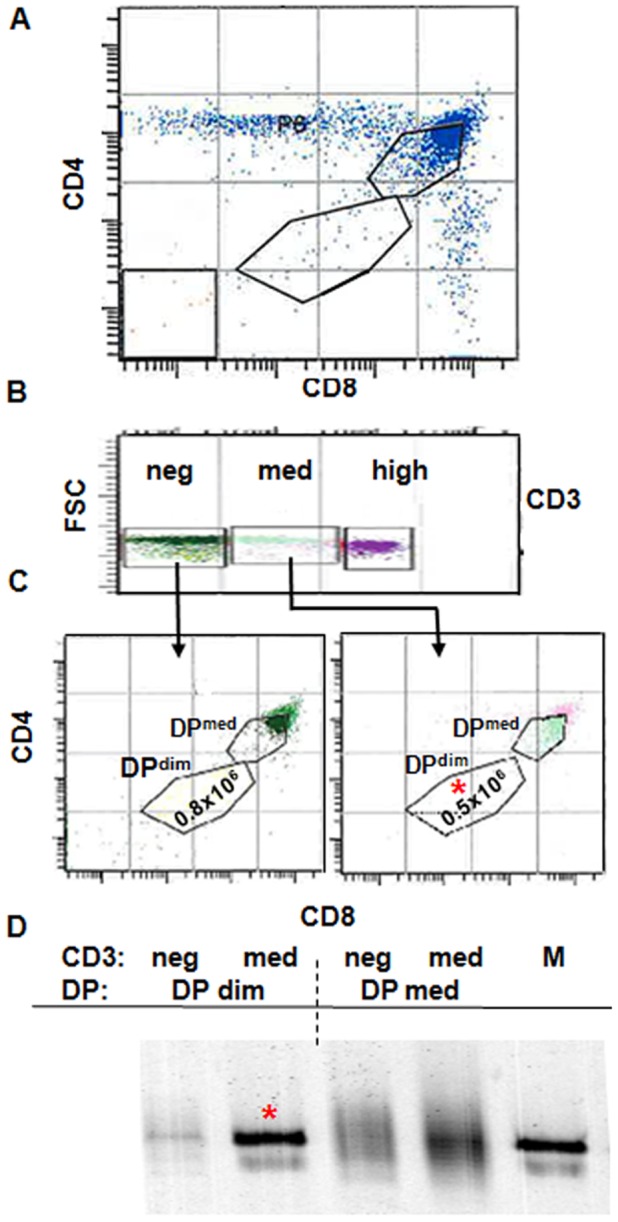
Thymocytes with iNKT rearrangements are found in the DPdim population.A. FACS profile of thymocytes based on CD4 and CD8 expression and defined gates for DPdim and DPmed thymocytes. B. FACS profile of thymocytes based on CD3 expression and defined gates for CD3neg, CD3med and CD3hi. C. FACS profile of thymocytes based on CD4 and CD8 expression through CD3neg and CD3med populations. Numbers inside DPdim gates represent the number of collected cells. D. Rearrangement analysis of Vα14-Jα18 in different sorted DP populations. The asterisk shows the population (CD3med DPdim) in which iNKT cells are observed, and lane “M” represents the iNKT rearrangement in the spleen of wild type C57BL/6 mouse and serves as size marker.